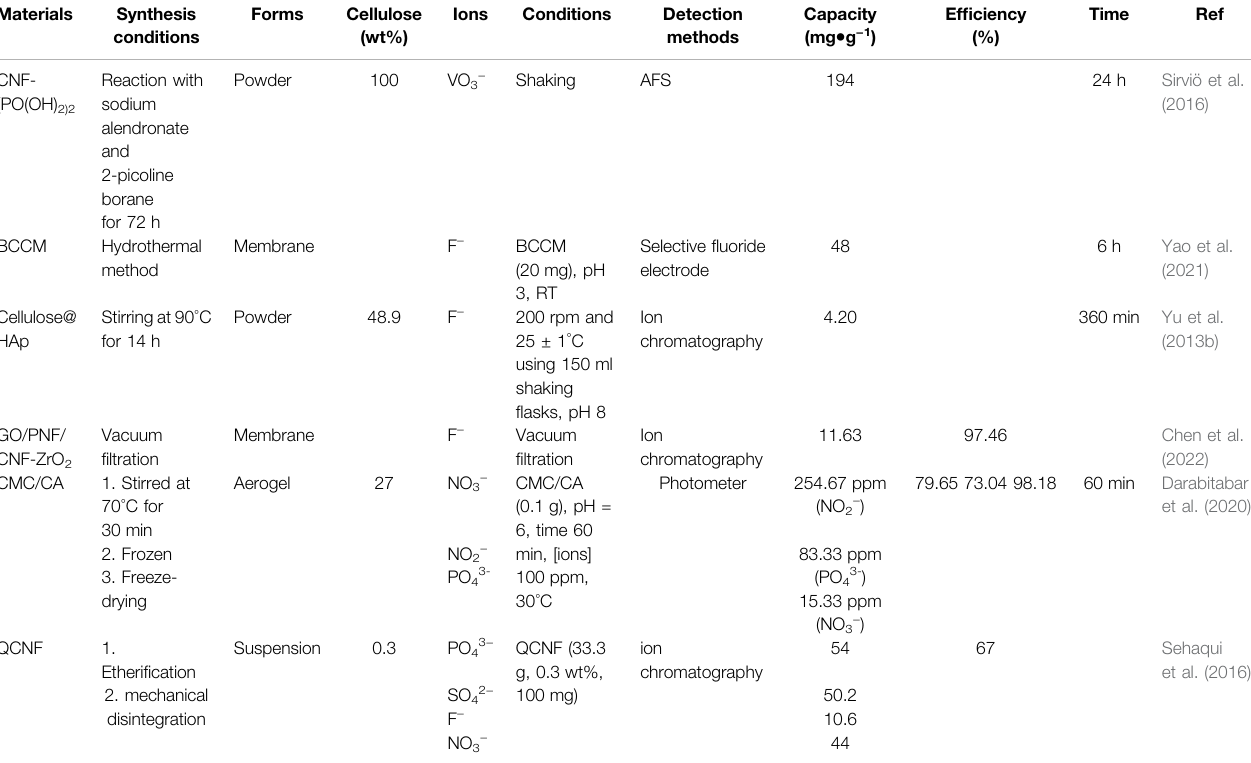
TABLE 3 | Adsorption of anionic species using Cellulose-based